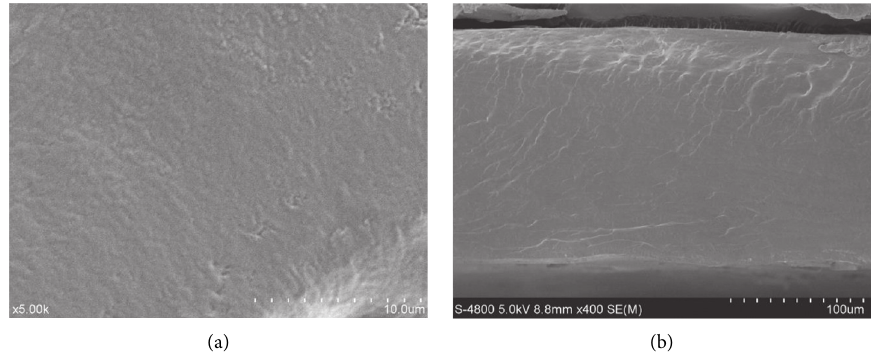
Figure 4: The micrographs of optimized complex film (a) Surface. (b) Cross